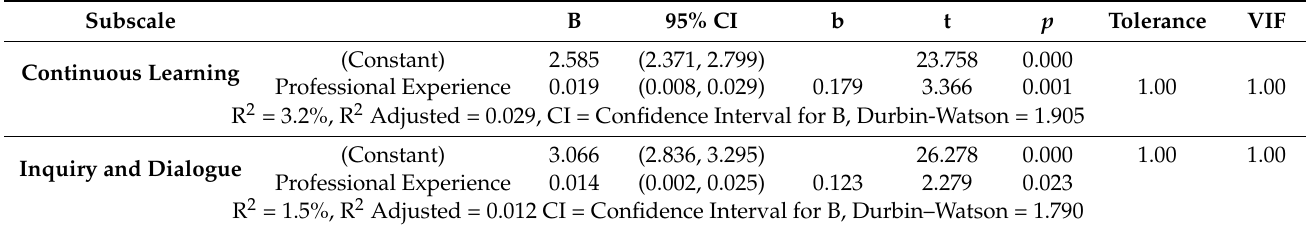
Table 9. Summary statistics of simple linear regression coefficients.